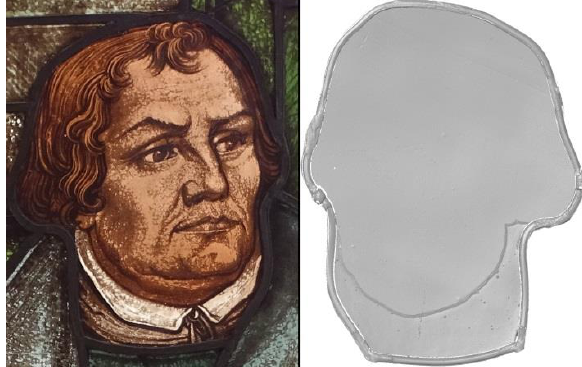
Figure 10. Left: transmitted light image of the glass pane from nXI3b (Oleszczuk 2019). Right: view of the outside (3D scan).